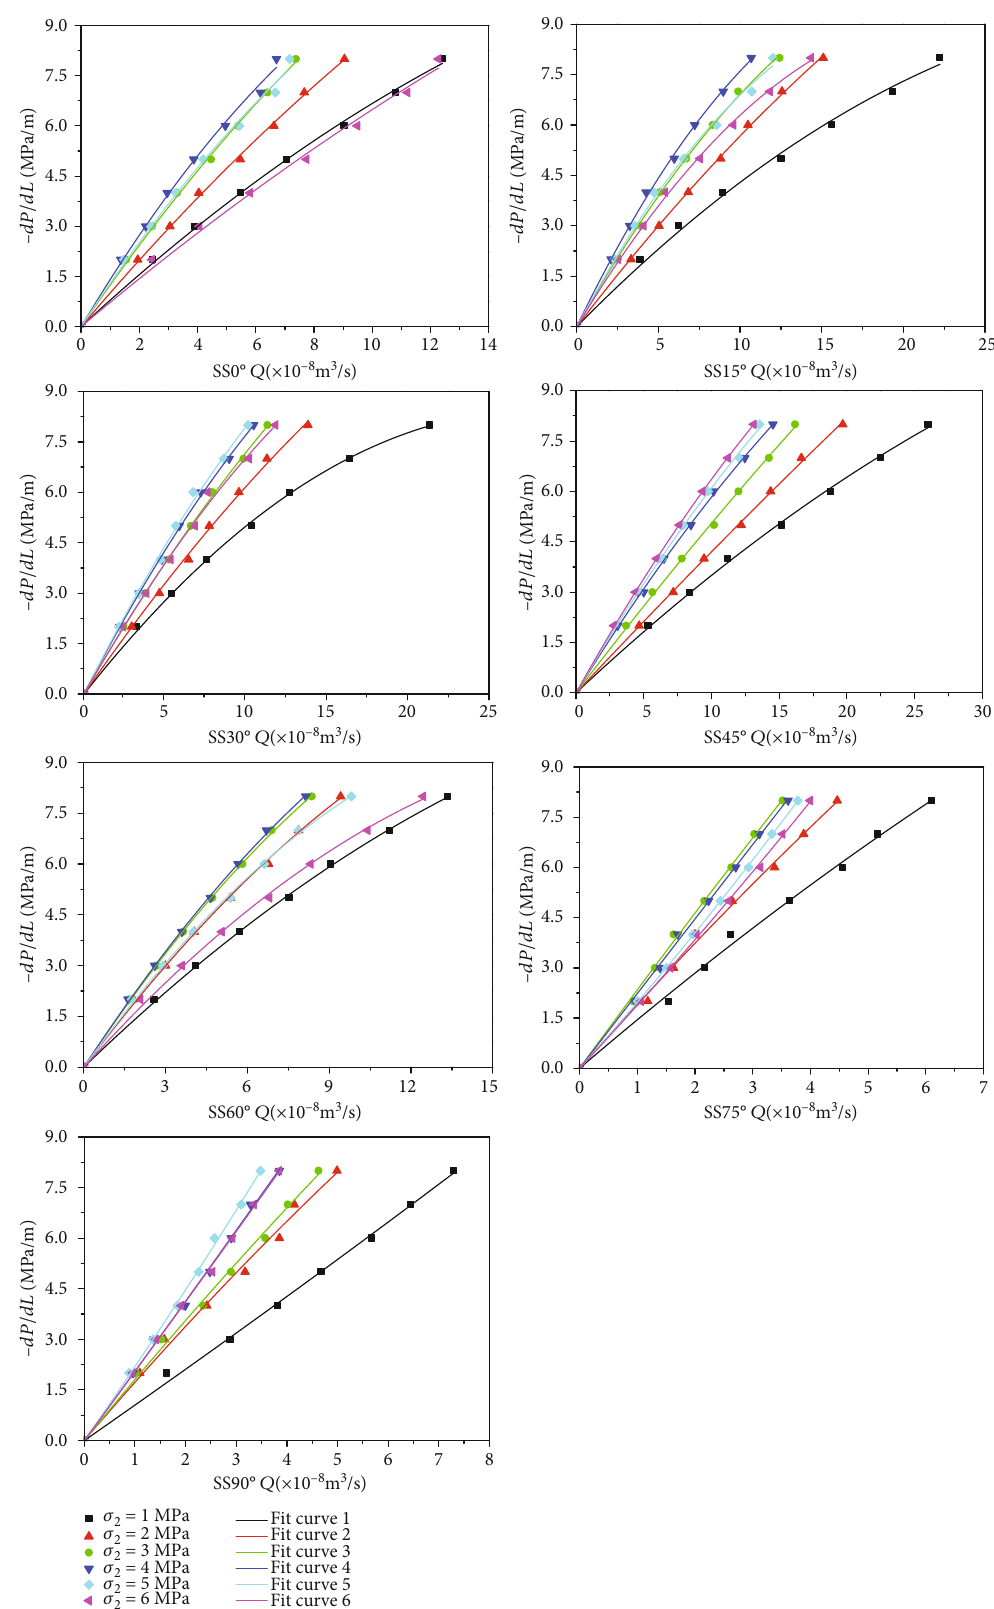
Figure 6: Relationship between volume velocity and pressure gradient for samples with di ff erent dip angles under intermediate principal